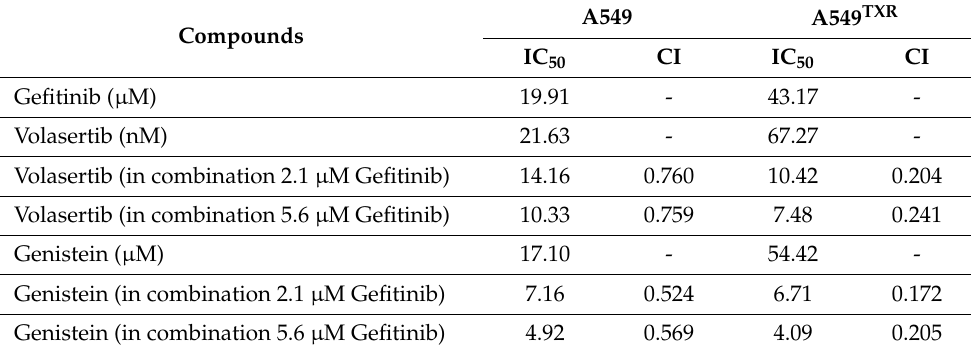
Table 2. The half maximal inhibitory concentration (IC 50 ) values of gefitinib, volasertib, and genistein and the combination index (CI) values in A549 and A549 TXR